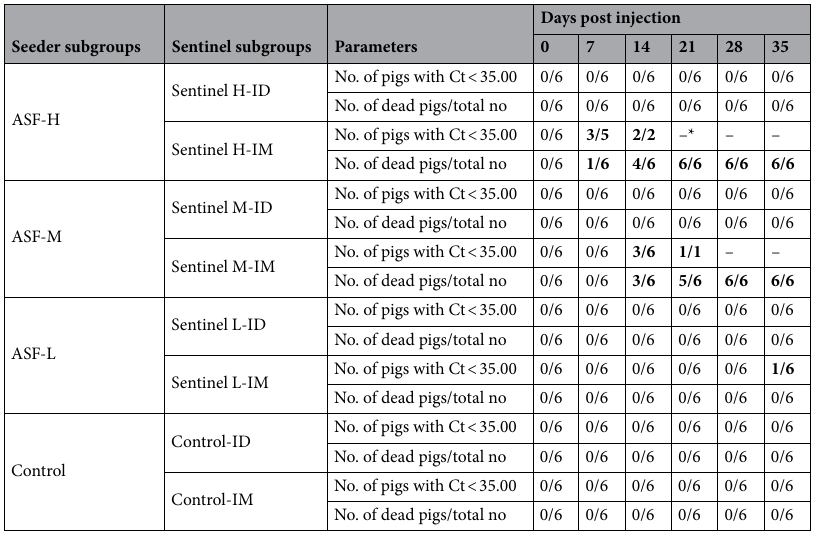
Sentinel pigs exposed via needle injection. One of the six sentinel pigs that received an IM injection with a needle used after previous injection to a seeder pig from the ASF-L subgroup developed viremia on D35 post-injection (PI). This pig was asymptomatic at the time of euthanasia (termination of the study). All the six sentinel pigs that received an IM injection with a needle used after previous injection of a seeder pig from the ASF-M subgroup died before D28 PI. Three of them had died before D14 PI, the remaining three having detectable viremia by this date and died over the following days. All the six sentinel pigs that received an IM injection with a needle used after previous injection of a seeder pig from the ASF-H subgroup died before D21 PI. The first pig death in this group was registered before D 7 PI. By this date, 3 out of the 5 remaining pigs had developed viremia and died or were euthanized over the next week. The 2 surviving pigs at D14 PI were also viremic and died at D 17 PIP.